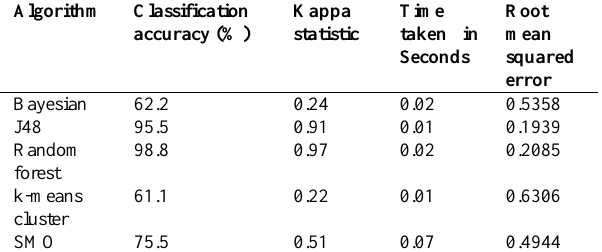
Table 3. Classification accuracy of the different algorithms in surface data set.